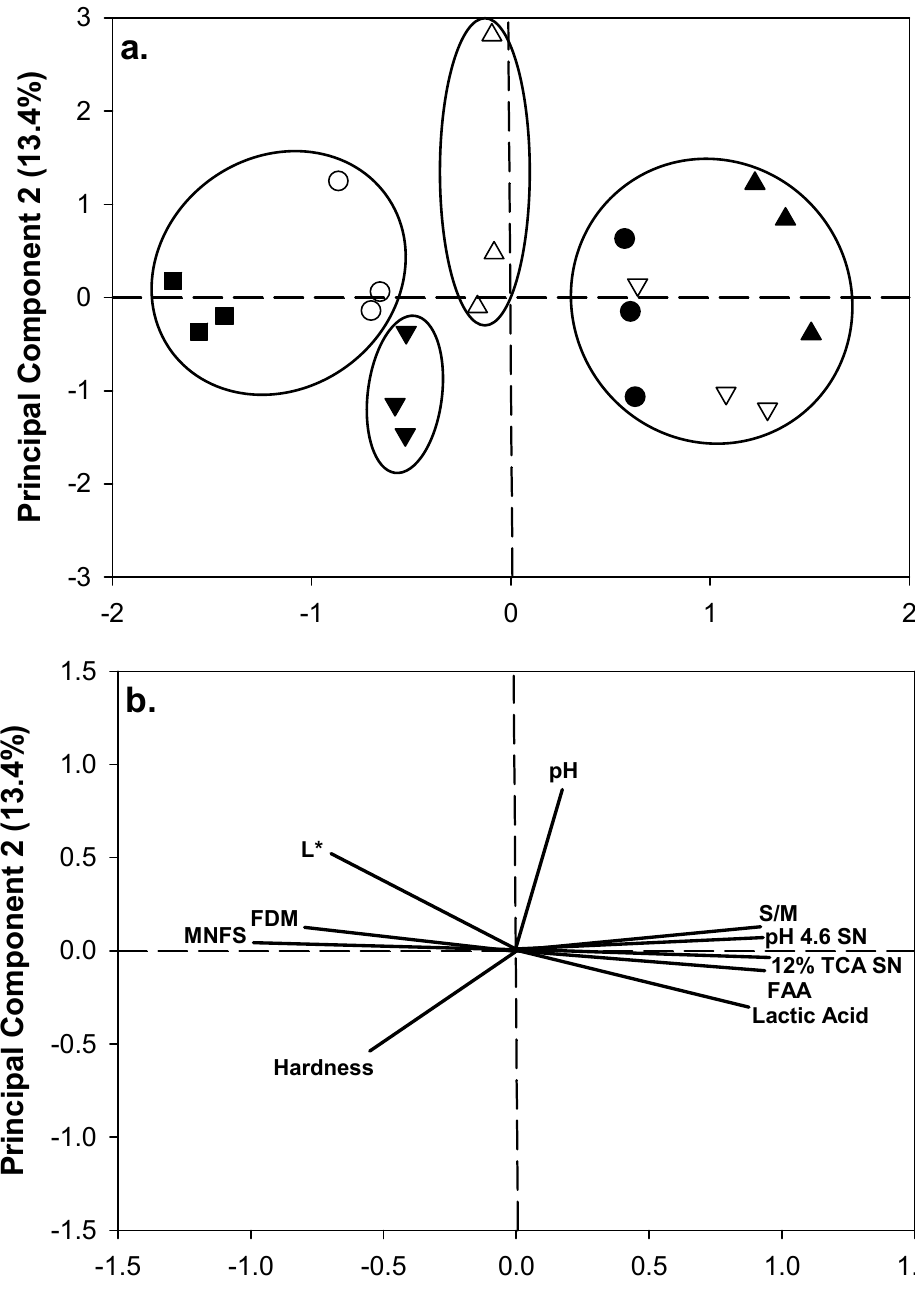
Figure 2. Score plot ( a ) and loading plot ( b ) obtained by principal component analysis (PCA) from selected physicochemical variables of Mexican Manchego-style cheese manufactured with hair sheep milk at 1 ( ■ ), 30 ( ○ ), 60 ( ▼ ), 90 ( △ ), 120 ( ● ), 150 ( ▽ ) and 180 ( ▲ ) d of ripening. Grouping of samples was based on a hierarchical cluster analysis (HCA).